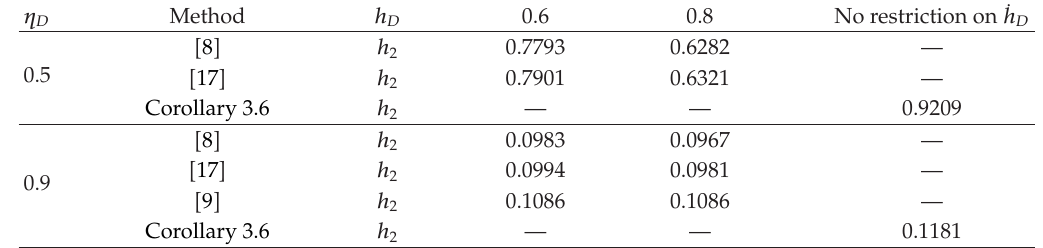
Table 2: Upper delay bound h 2 with h 1 (cid:9)